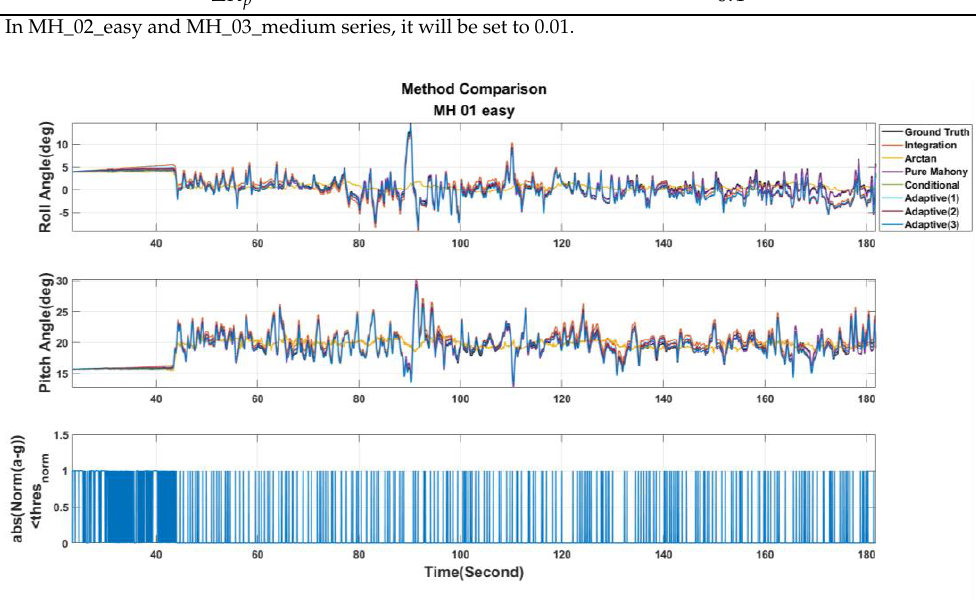
Figure 13. Roll and pitch angles were obtained from different adjustment strategies for the MH_04_diffi- cult series. Table 4. Results of online adaptive p K tuning algorithm for EuRoC dataset. (Unit: deg). Method\Series